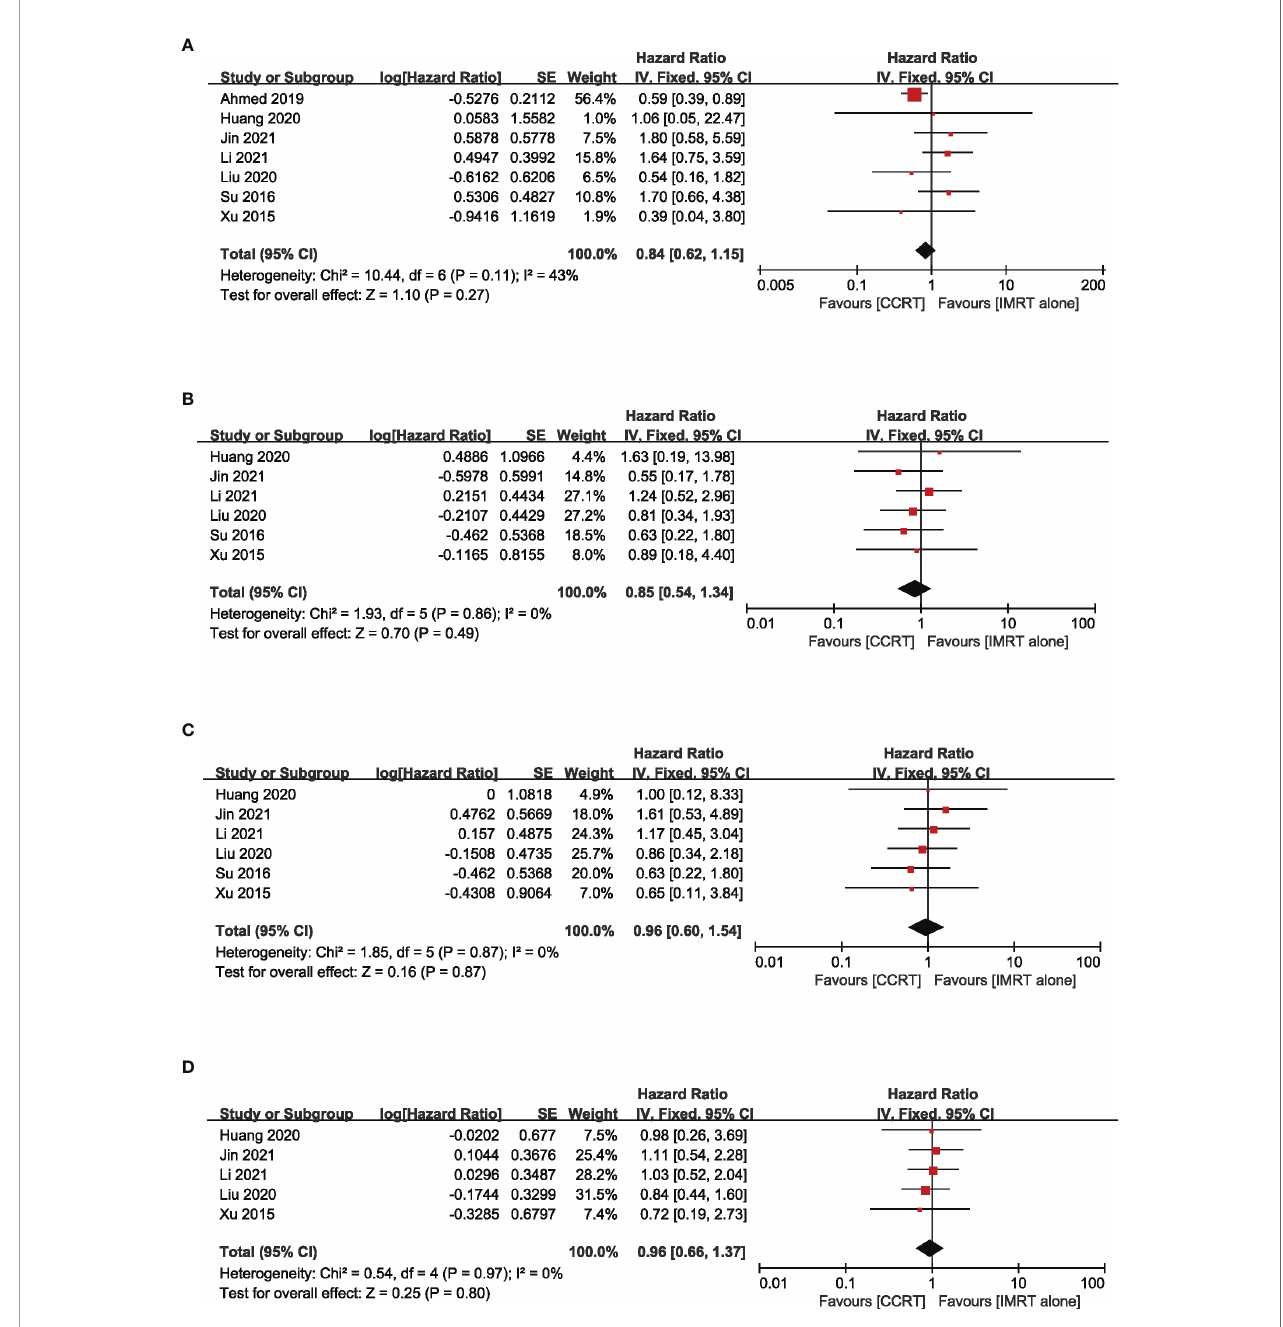
FIGURE 4 | Forest plot of the meta-analysis regarding OS (A) , LRFS (B) , DMFS (C) , and PFS (D) with CCRT vs. IMRT alone. IMRT, intensity-modulated